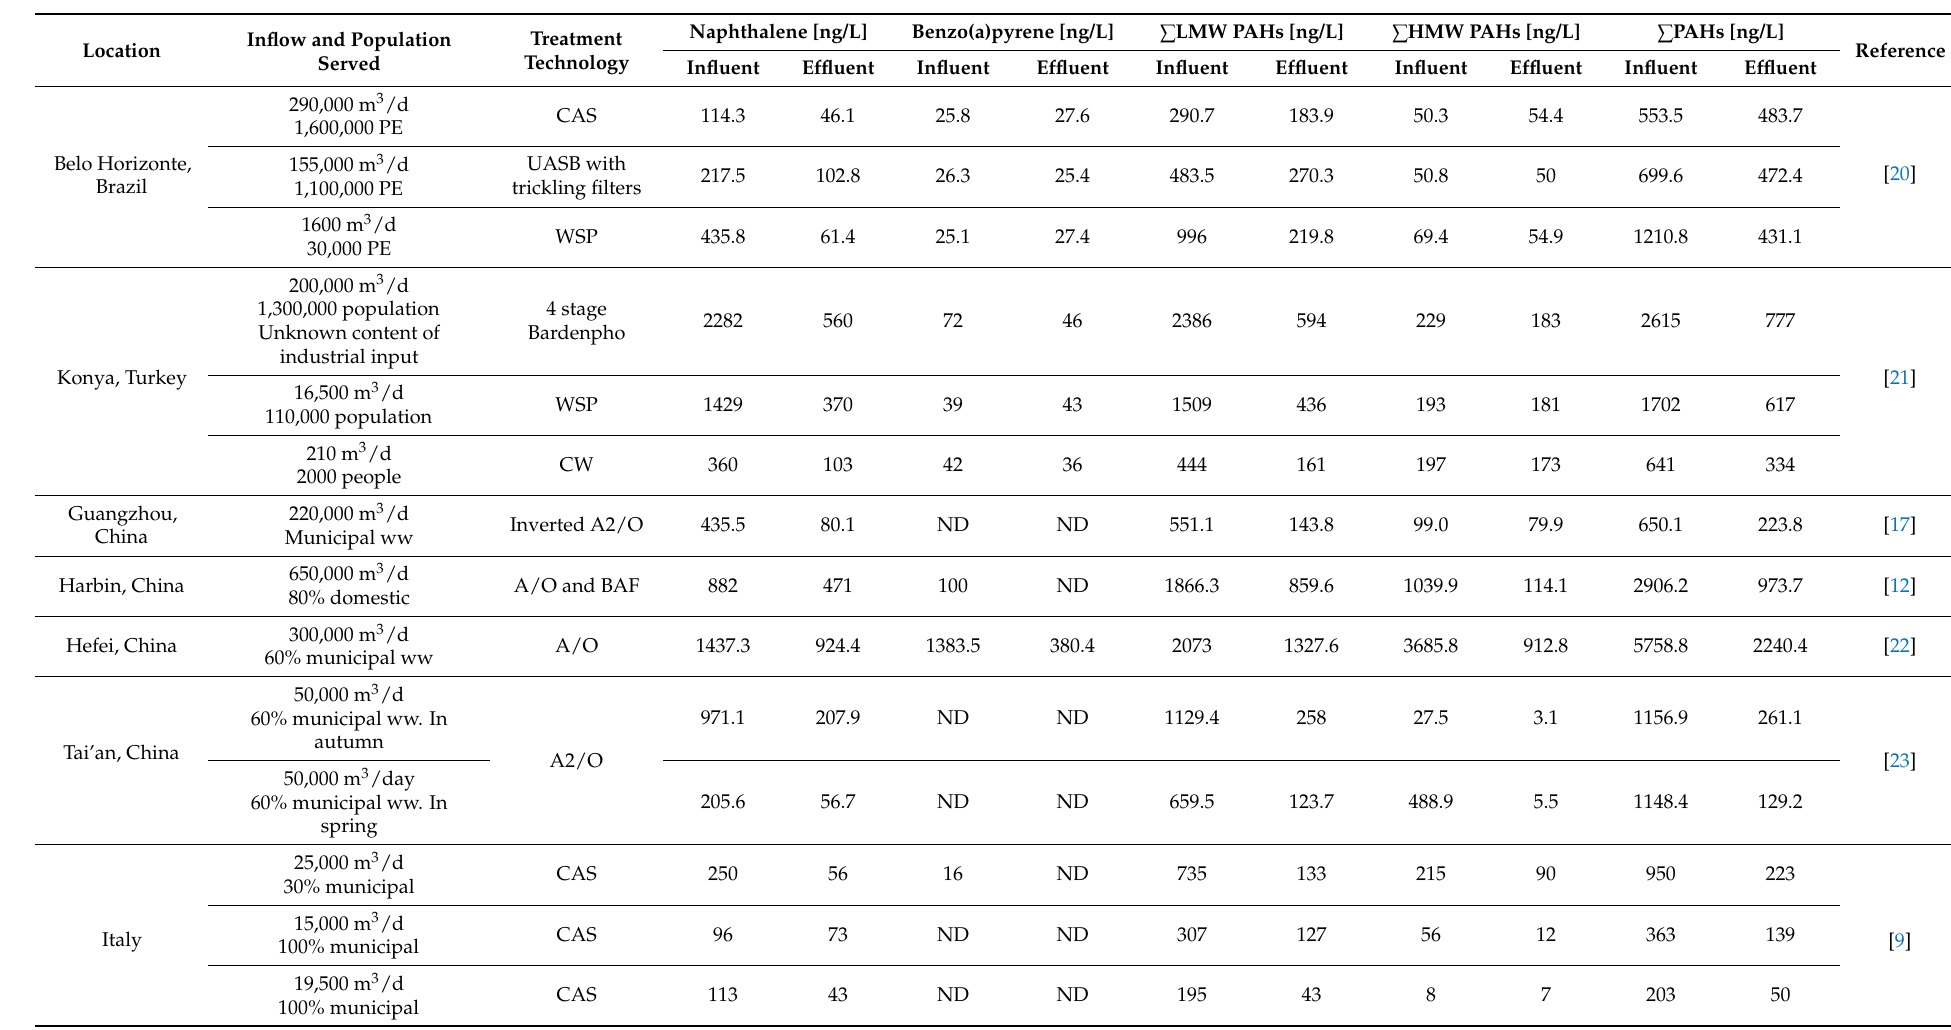
Table 1. Summary of influent and effluent concentration of PAHs in WWTPs worldwide. For WWTPs with industrial inputs, the percentage of domestic/municipal WW is provided.